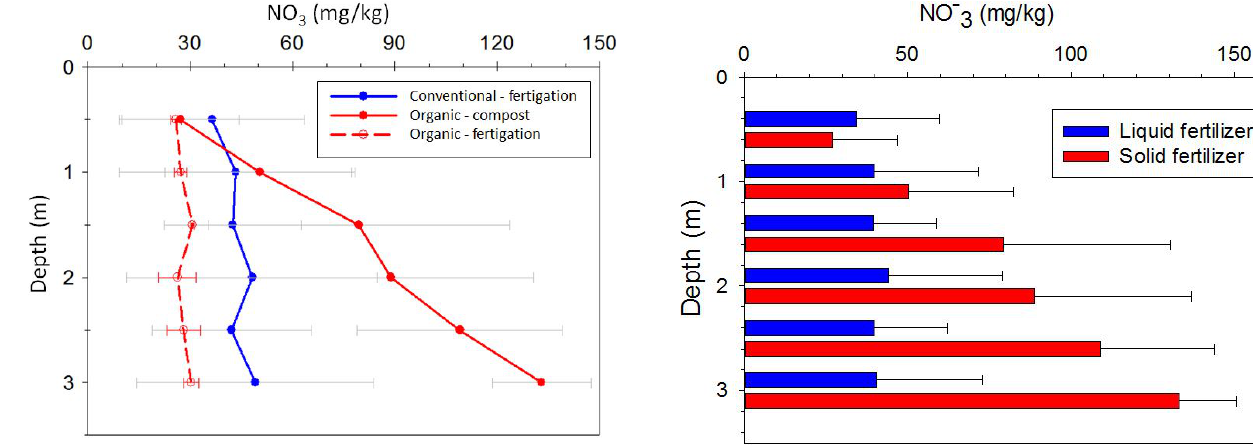
Fig. 8. Nitrate concentrations in the vadose zone underlying green- houses fertilized by solid fertilizers as compost and guano and liq- uid